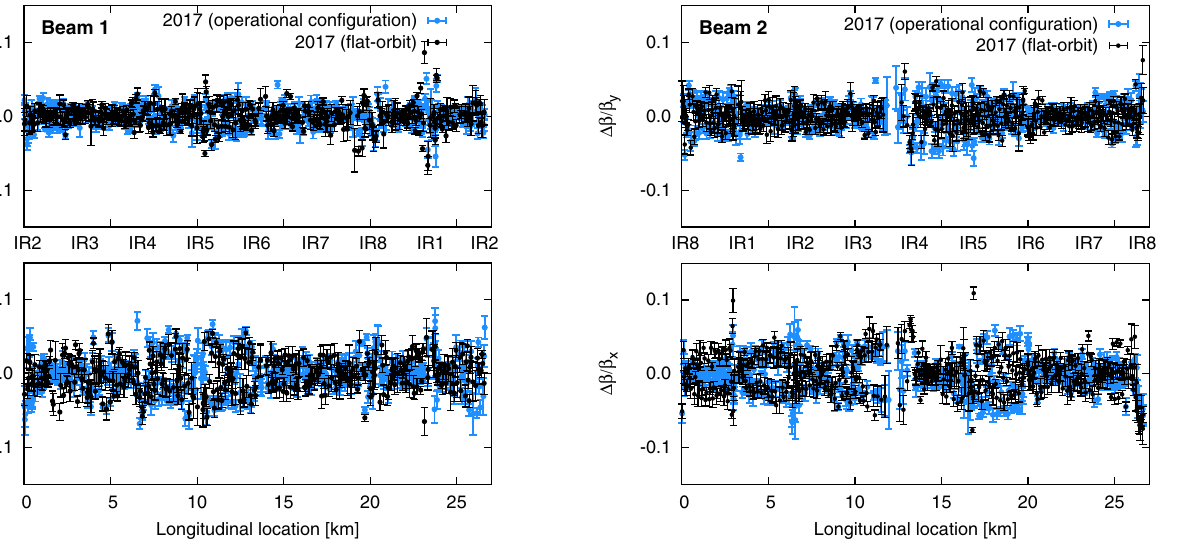
FIG. 29. β -beat in Beam 2 measured for at flat orbit and the operational configuration at β (cid:1) ¼ 0 . 4 m